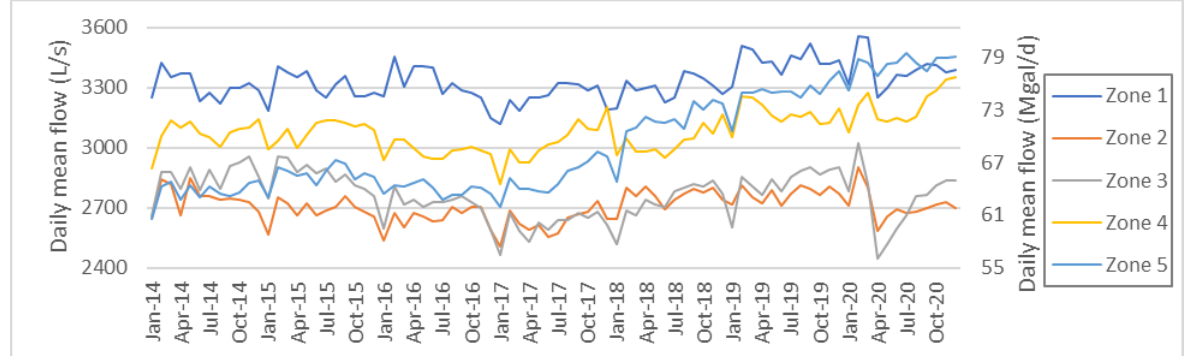
Figure 5. Monthly daily mean flow for supply zones in Bogotá.